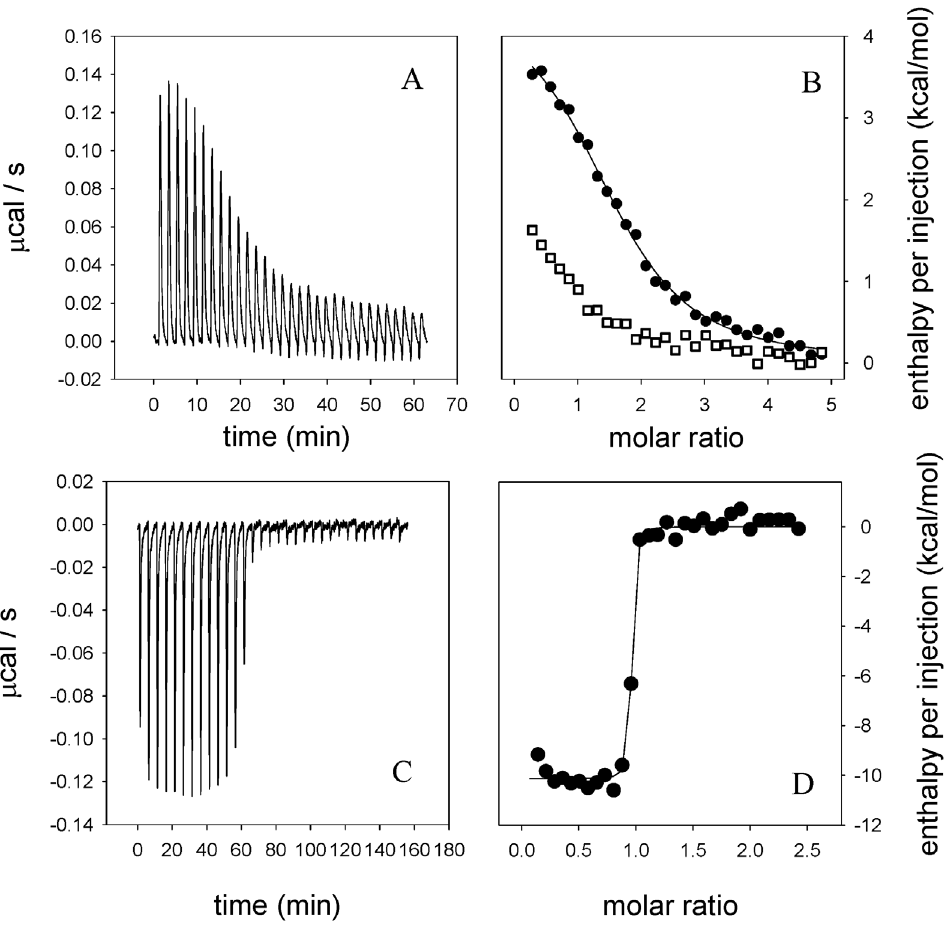
Figure 5. Evaluation of heme binding with BBPLo and NP2 using isothermal titration calorimetry. (a) Heats observed on injection of hemin (100 m M) into a solution of BBPLo (5 m M) under conditions described in the materials and methods. (b) Binding enthalpies plotted as a function of molar ratio for the data in panel (a) (filled circles). The line represents a fit to a single binding site model, giving the following thermodynamic parameters: D H=4.5 ( 6 0.1) kcal/mol, T D S=12.5 kcal/mol, K=6.6 ( 6 0.55) 6 10 5 M 2 1 . Also shown are the enthalpies (open squares) obtained when the same experiment is performed in the presence of 2 m M biliverdin IX c . (c) Heats observed on injection of hemin (50 m M) into a solution of NP2 (5 m M) under conditions described in the materials and methods. (d) The line represents a fit to a single site binding model giving the following thermodynamic parameters: D H= 2 10.1 ( 6 0.1) kcal/mol, T D S=2.3 kcal/mol, K $ 9.1 6 10 8 M 2 1 .